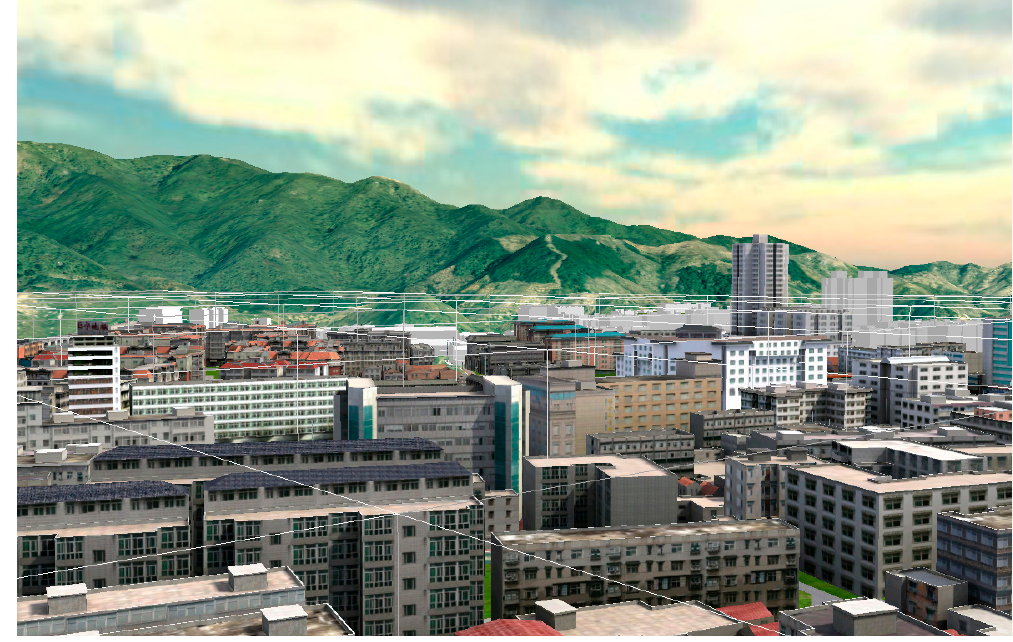
Figure 5. Scenario of the test area.